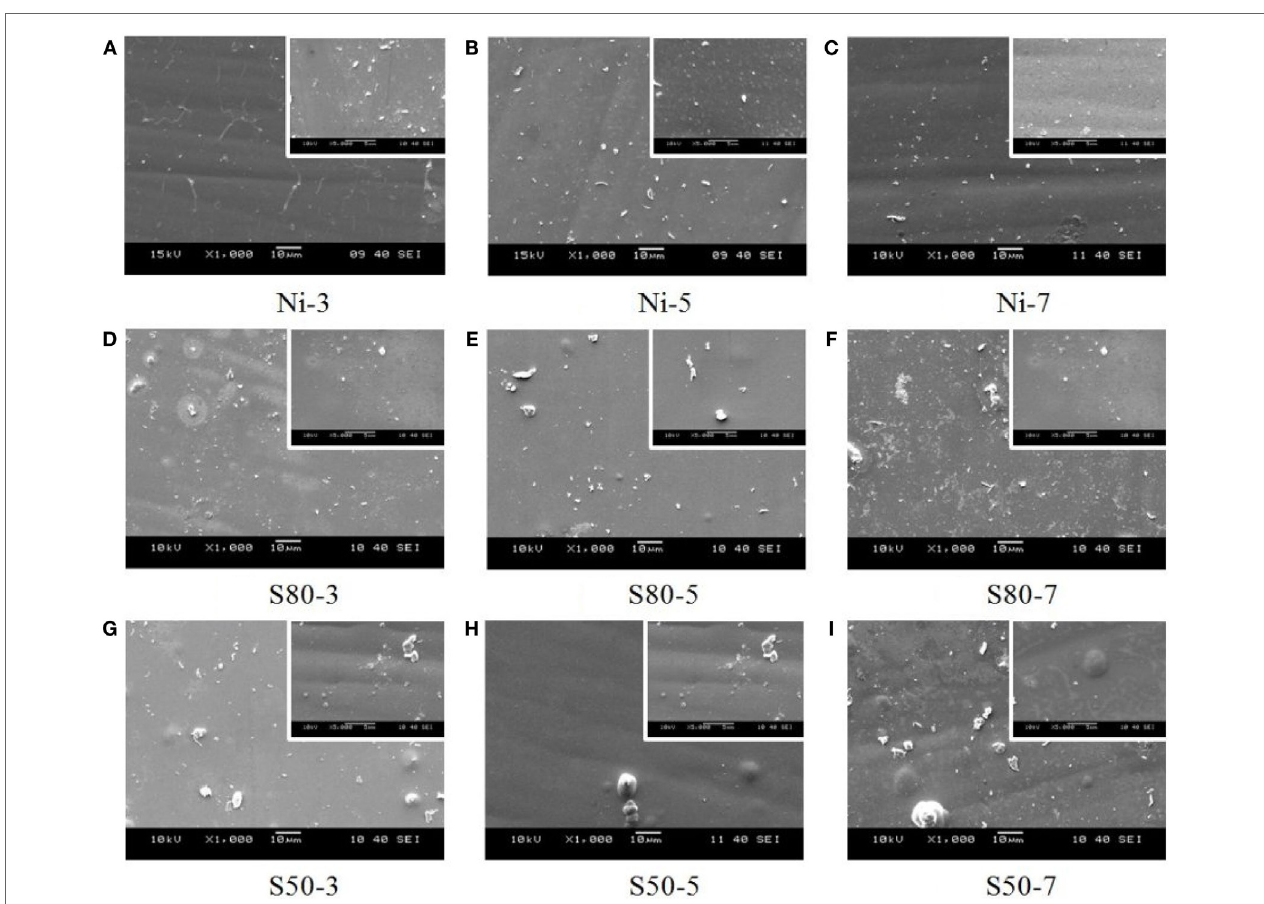
FigUre 2 | surface morphologies of (a–c) pure ni coatings, ni–TiO 2 nanocomposite coatings prepared with 80 nm sized nanoparticles (D–F), and 50 nm sized nanoparticles (g–i) at 1 g l − 1 concentration and 3, 5, and 7 a dm − 2 current densities